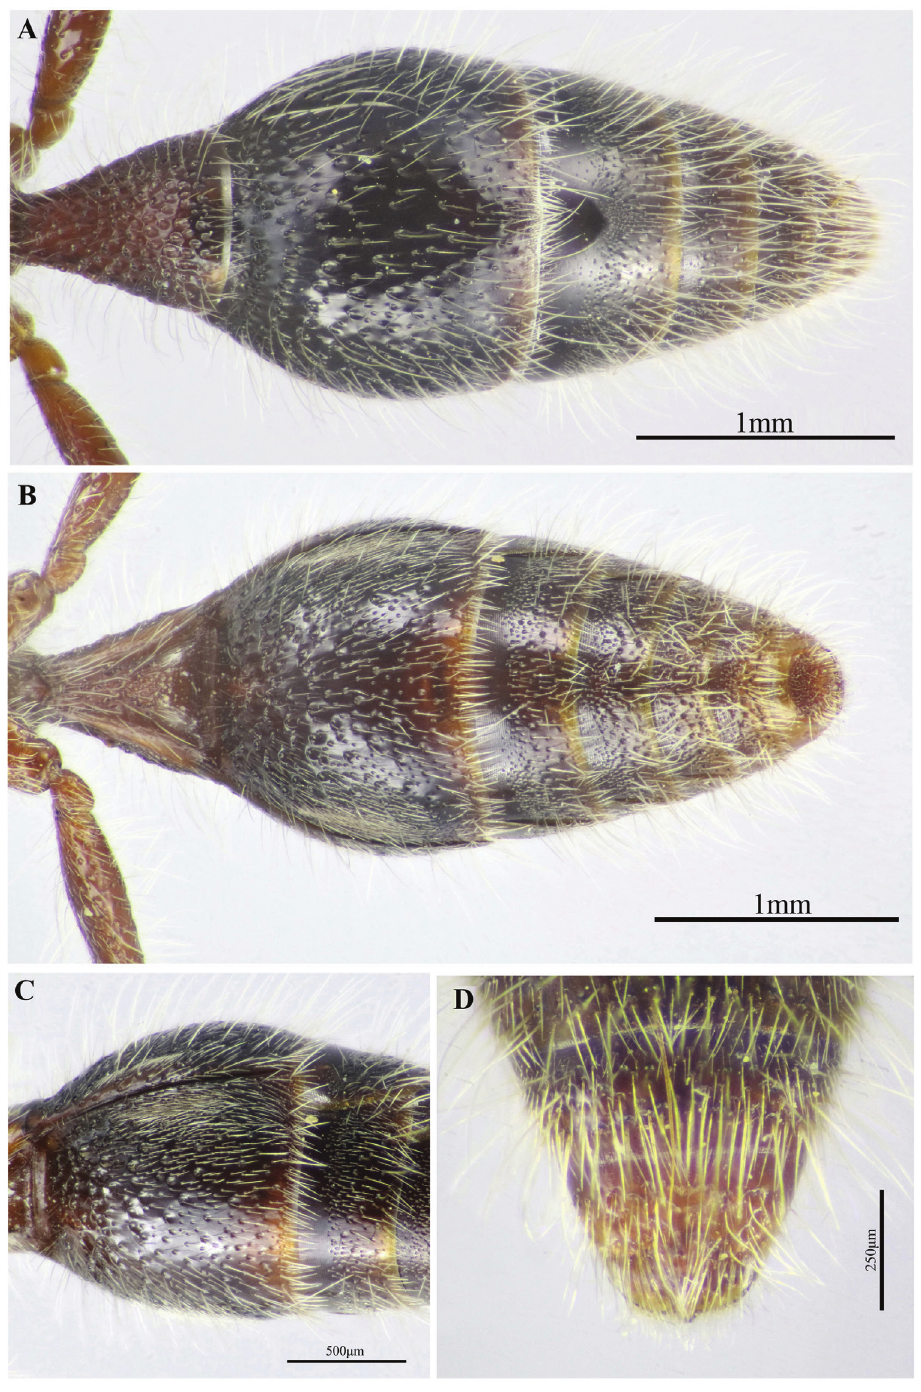
Figure 14. Pseudophotopsis dhofarensis sp. nov. (Male) A, B metasoma, dorsal and ventral views, respec- tively C 2 nd and 3 rd metasomal segments, ventro-lateral view D T6–T7, dorsal